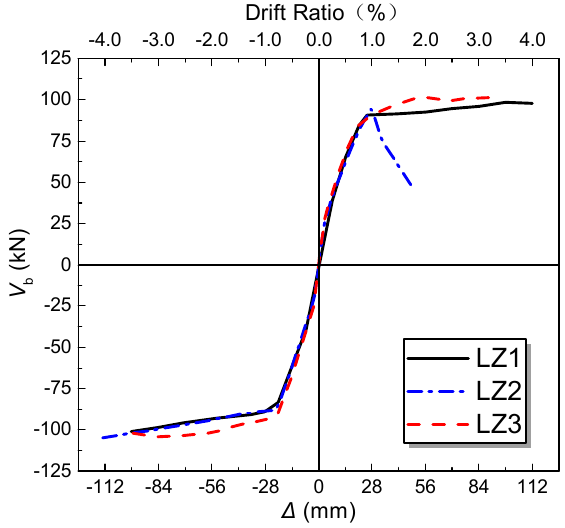
Figure 8. Skeleton curves of hysteresis loops.